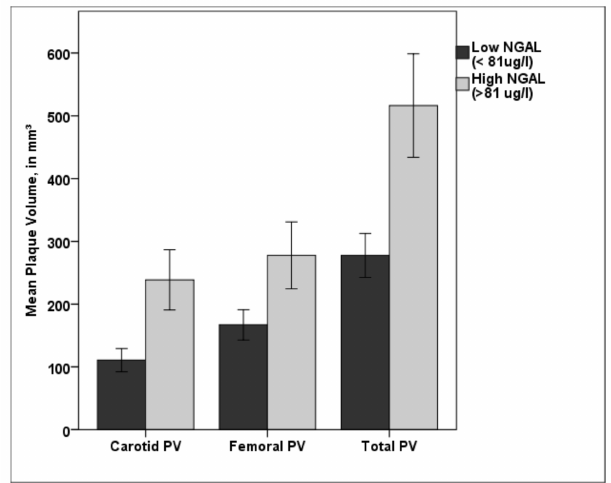
Figure 4. Bar diagram showing the di ff erence in carotid, femoral, and total PV for low NGAL ( < 81.18 µ g / L) and high NGAL ( > 81.18 µ g / L). Patients in the high NGAL group showed a significantly higher plaque burden in both vascular beds compared with patients in the low NGAL group. PV—plaque volume; NGAL—neutrophil gelatinase-associated lipocalin; * p < 0.001. Error bars indicate 95% confidence intervals.